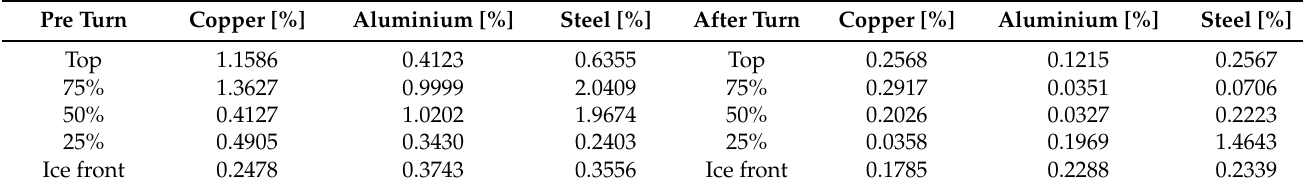
Table 2. Precision error at the symmetry line for the five data points as presented in Figure